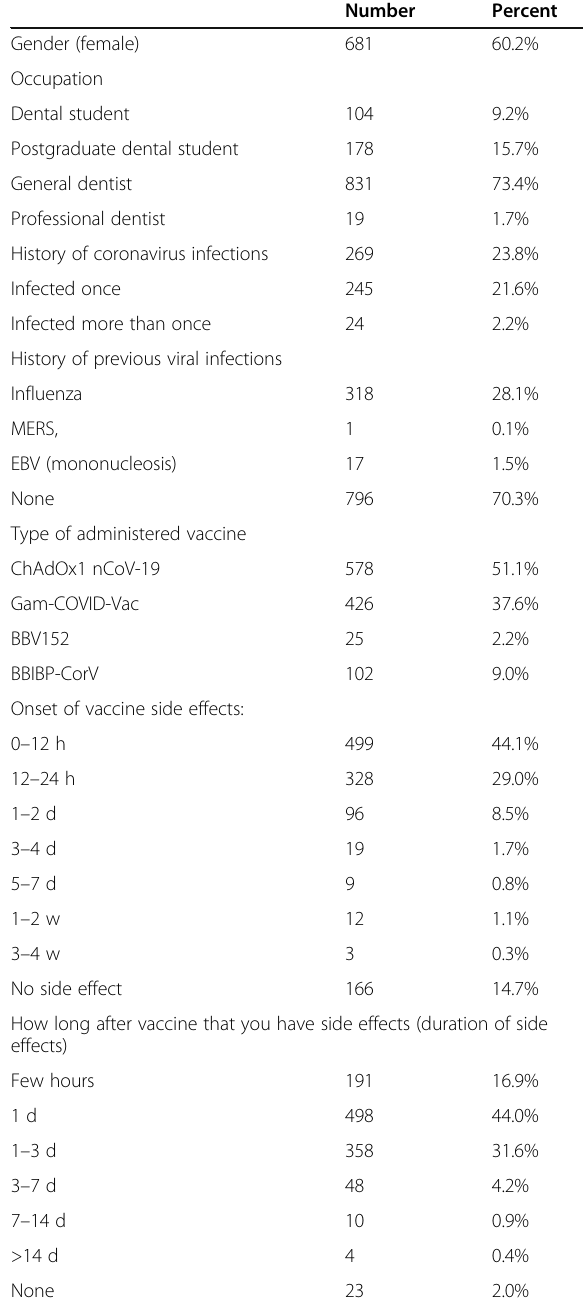
Table 1 The demographic data of included